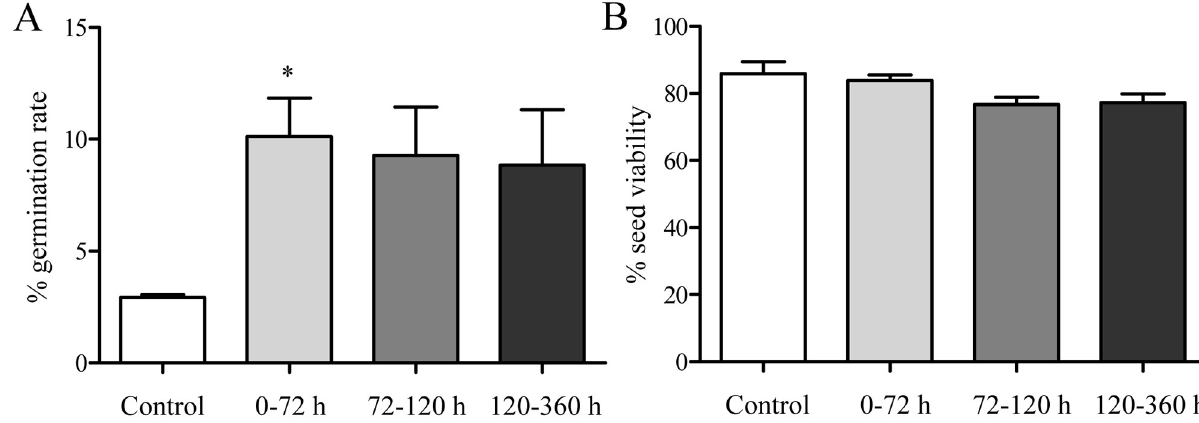
Fig 7. Effect of the DRT on C . spinosa seed germination rate and viability. (A) The germination rate of C . spinosa seeds with different DRTs. (B) The viability of C . spinosa seeds that did not germinate with different DRTs. The data were from 3 independent experiments and were analyzed by ANOVA. � P < 0.05 compared to the control group.